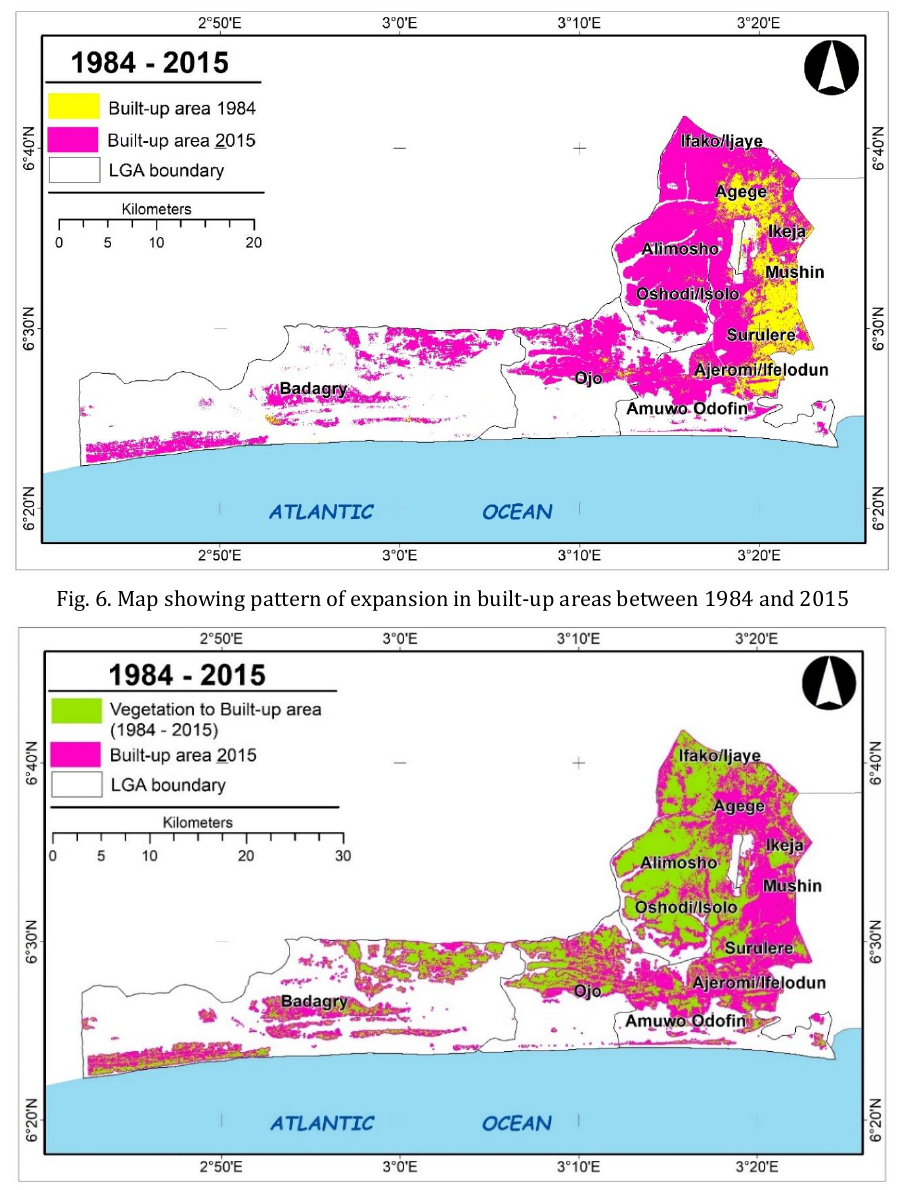
Fig. 7. Map showing transition from vegetation to built-up area between 1984 and